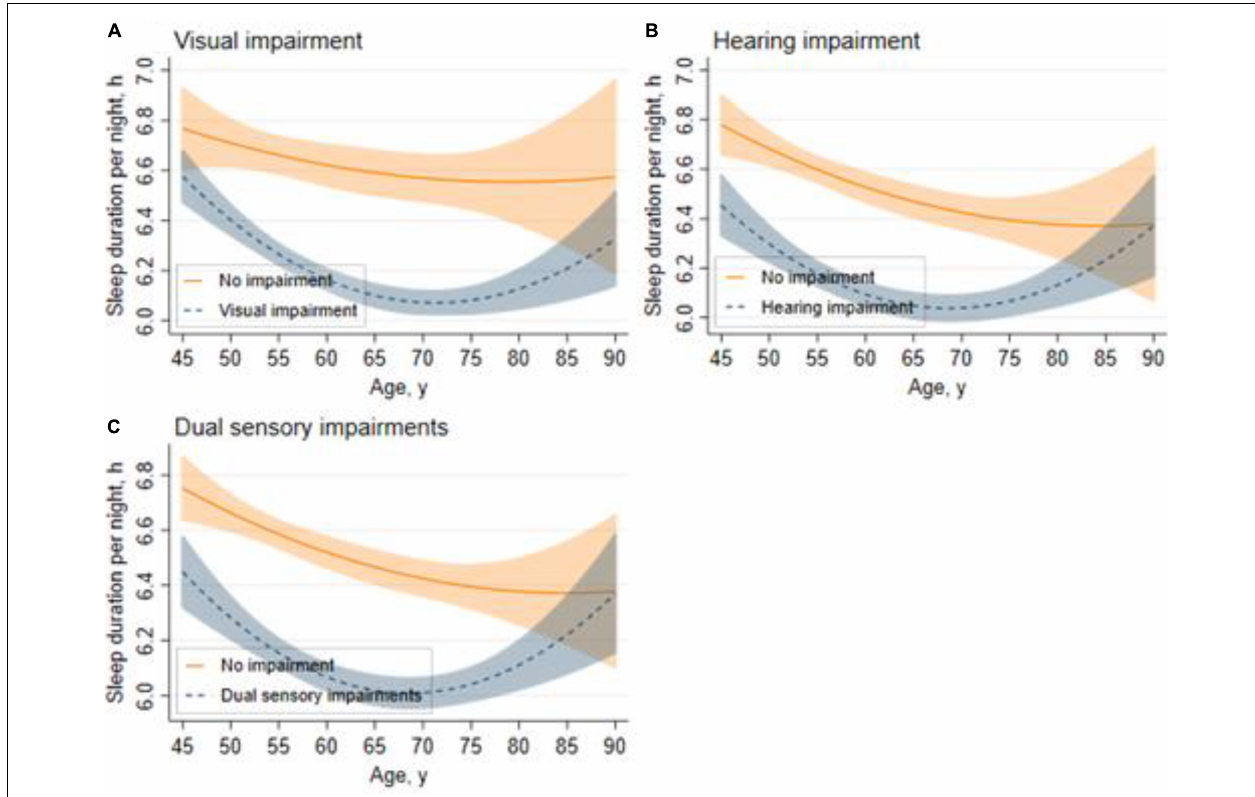
FIGURE 2 | Trajectories for sleep duration across different sensory impairment groups. Graphs display analog values (lines) of sleep duration with 95% CIs (shaded areas) for visual impairment (A) , hearing impairment (B) , and dual sensory impairments (C)